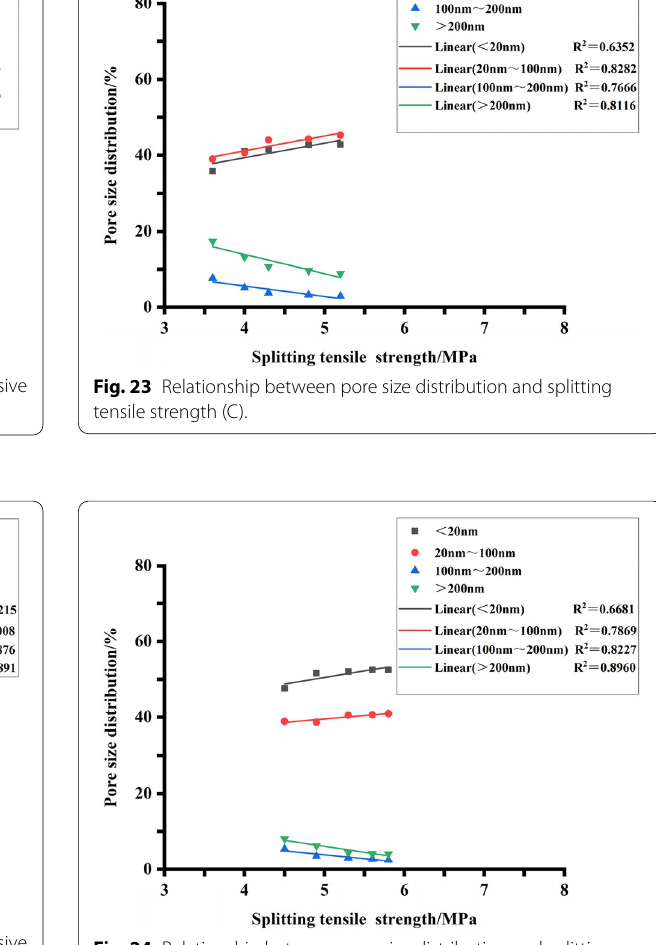
Fig. 24 Relationship between pore size distribution and splitting tensile strength